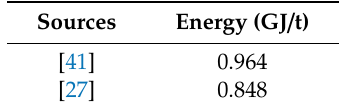
Table 8. Energy consumption per ton of